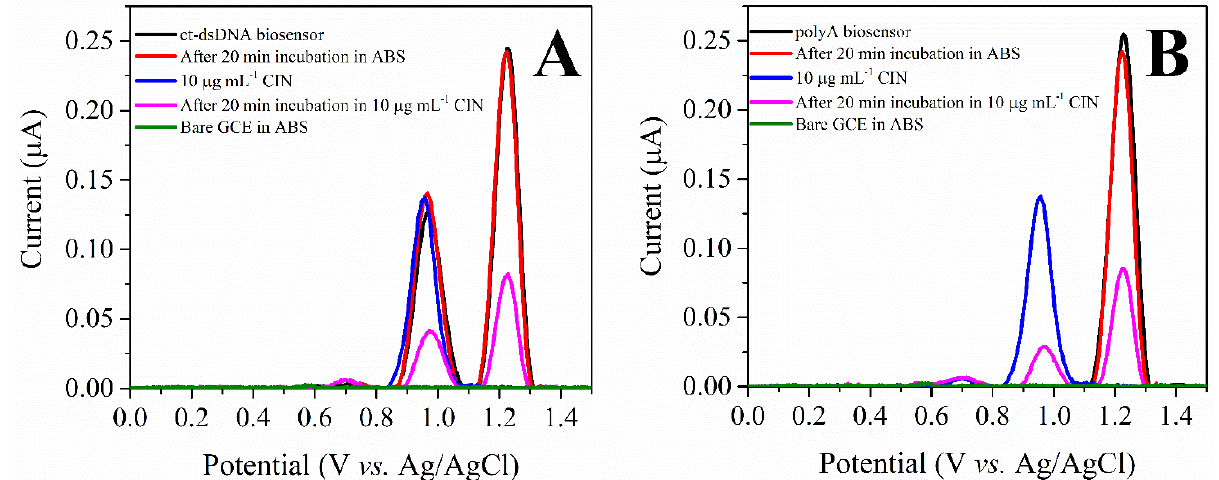
Figure 2. ( A ) DP voltammograms of the ct-dsDNA biosensor, 10 μg mL −1 CIN, the ct-dsDNA biosensor after incubation in ABS (pH 4.7), the ct-dsDNA biosensor after incubation in 10 μg mL −1 CIN, and the bare GCE in ABS (pH 4.7), ( B ) DP voltammograms of polyA biosensor, 10 μg mL −1 CIN, the polyA biosensor after incubation in ABS (pH 4.7), the polyA biosensor after incubation in 10 μg mL −1 CIN, and the bare GCE in ABS (pH 4.7).